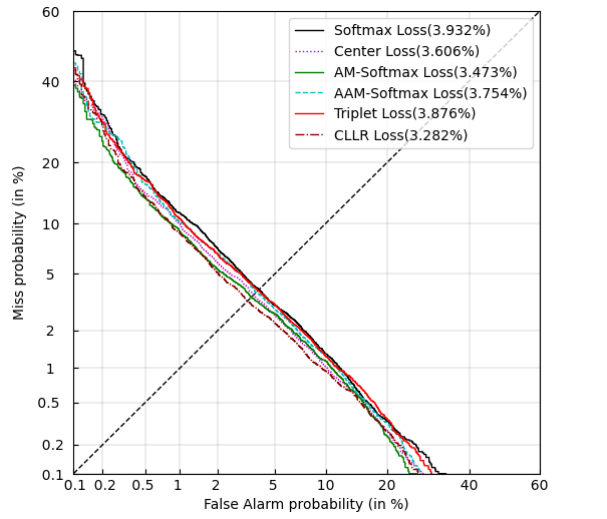
Figure 3. The detection error trade-off (DET) curve for VoxCeleb test results of the different loss